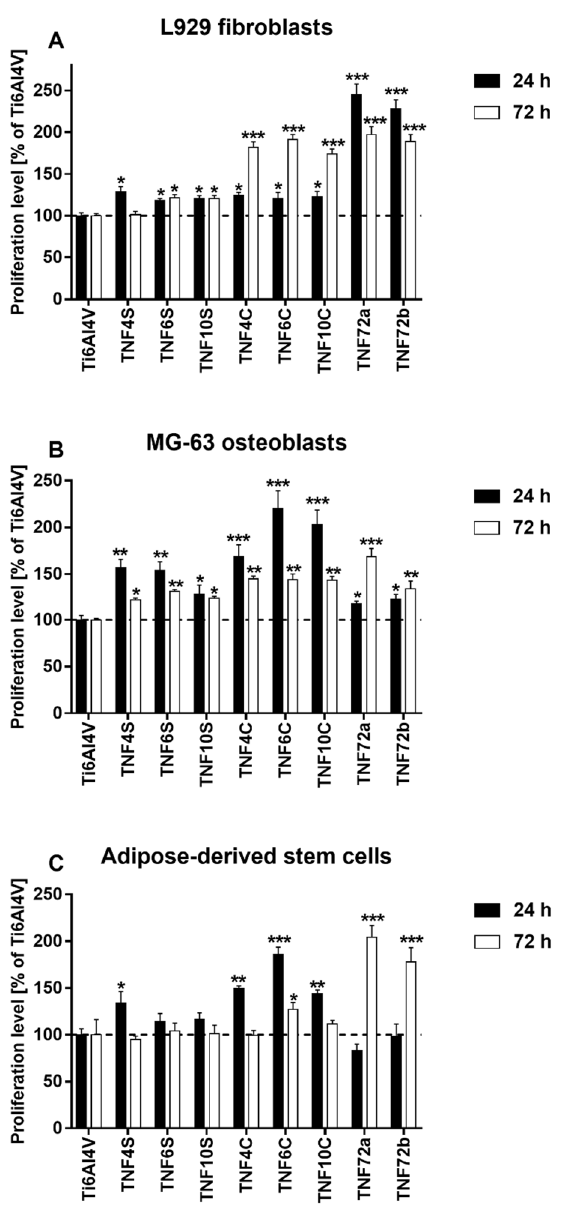
Figure 5. Proliferation level of L929 murine fibroblast cells ( A ), human osteoblast-like MG 63 cells ( B ) and human adipose-derived mesenchymal stem cells ( C ) growing on the surface of fibrous nanocoatings, in comparison with the reference Ti6Al4V alloy foils. Cell viability was assessed using the MTT assay after 24 and 72 h of culture. The results are expressed as percentage of the cells cultured on the reference Ti6Al4V alloy foils (served as 100%). The percentage values are expressed as means ± SEM of four independent experiments. Asterisks indicate significant differences at the appropriate time (after 24 or 72 h) between the level of cell viability on the surface of the tested specimens compared with the reference Ti6Al4V alloy foils (Ti6Al4V) (*** p < 0.001, ** p < 0.01; * p < 0.05). The horizontal lines show the proliferation level of the control cells growing on the reference Ti6Al4V alloy foils.